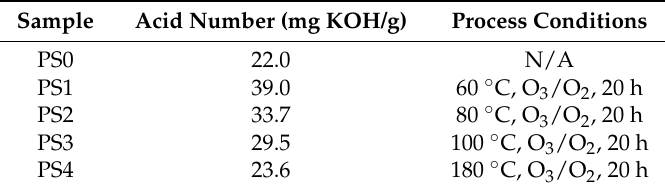
Table 1. Conditions and acid number results of thermal degradation procedure on PS0 flakes.